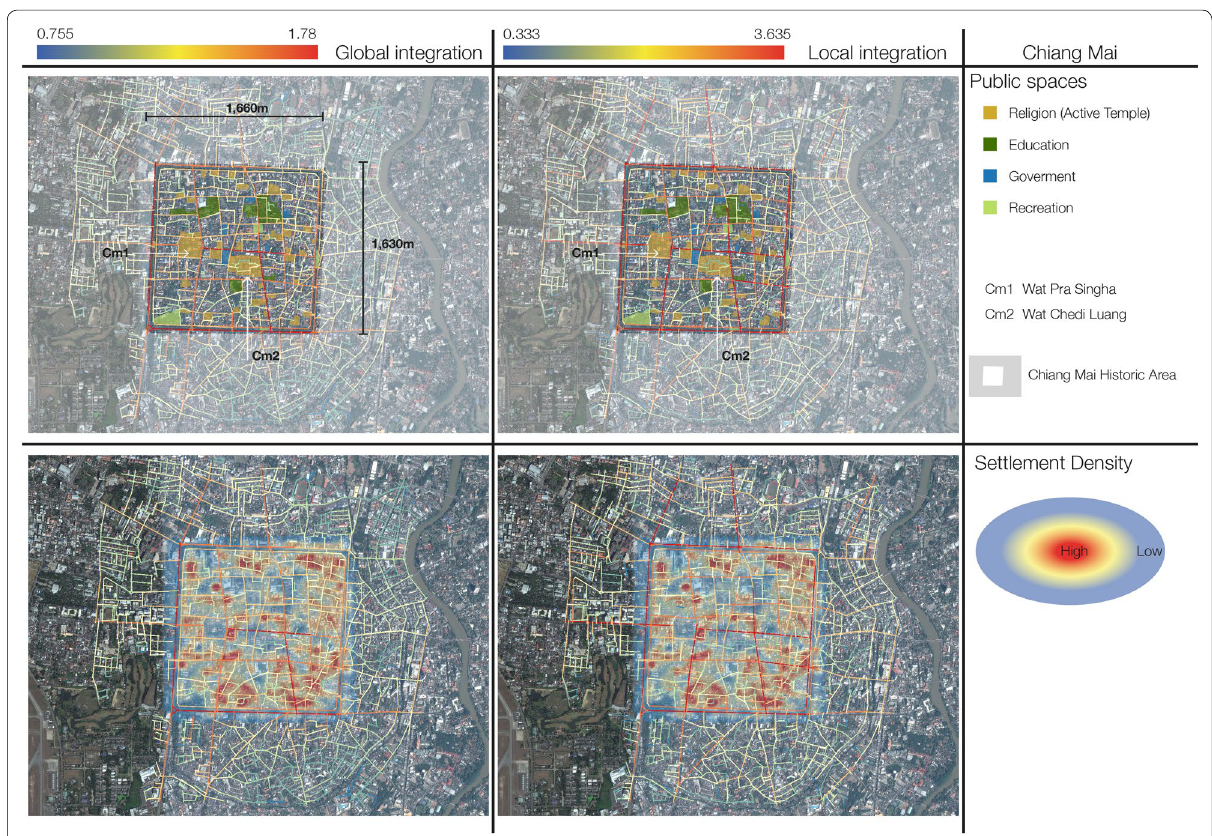
Fig. 9 Analysis of Chiang Mai’s spatial